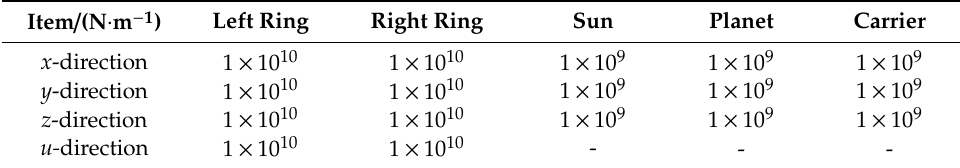
Table 2. HPGT sti ff ness